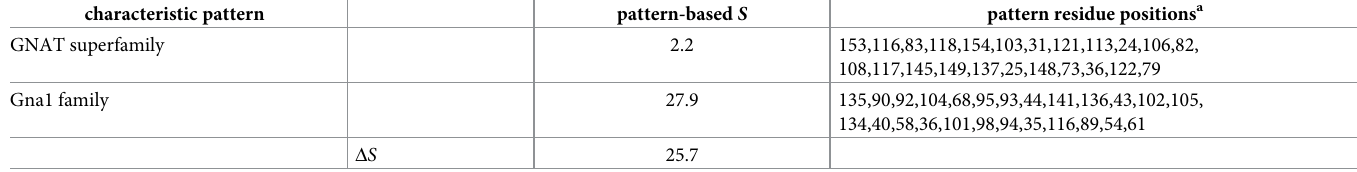
a Pattern residues were determined in [39, 42]; positions are ordered by decreasing BPPS